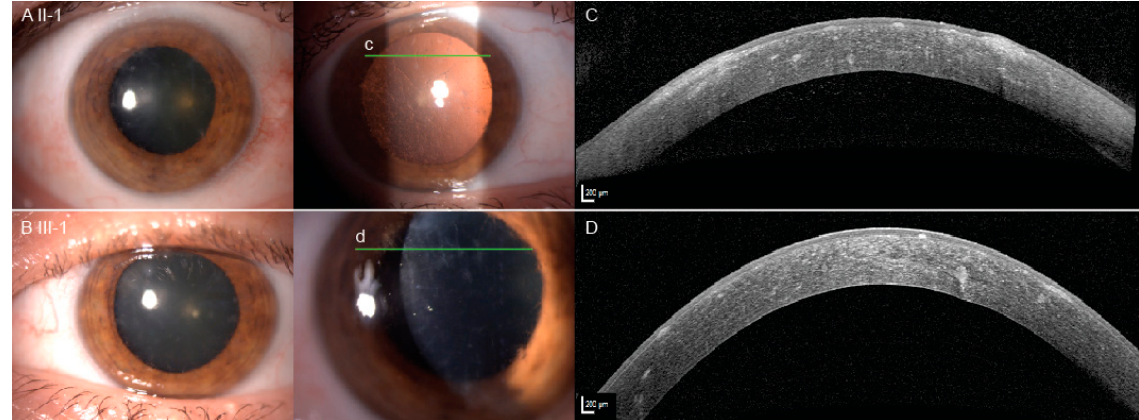
Figure 1. Slit lamp pictures ( A , B ) and the anterior segment optical coherence tomography ( C , D ) of the patients II-1 and III-1. The lines c and d mark the location of the optical coherence tomography (OCT) scans. Note the thick anterior and midstromal filaments on the OCT.